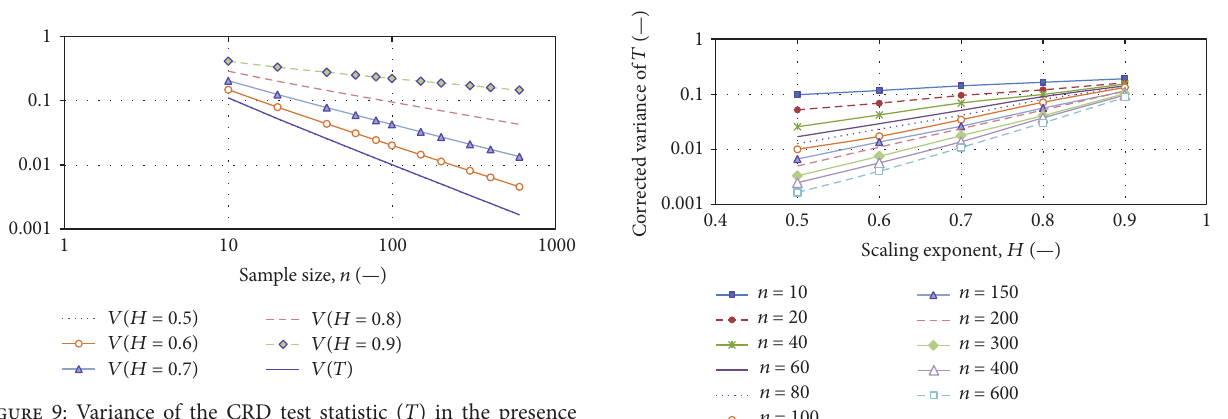
Figure 9: Variance of the CRD test statistic ( T ) in the presence of scaling exponent H . In the legend, 𝑉(𝑇) denotes the original variance without considering the influence of scaling, and, for example, 𝑉 ( 𝐻 = 0.8 ) indicates the variance of T when 𝐻 = 0.8 .